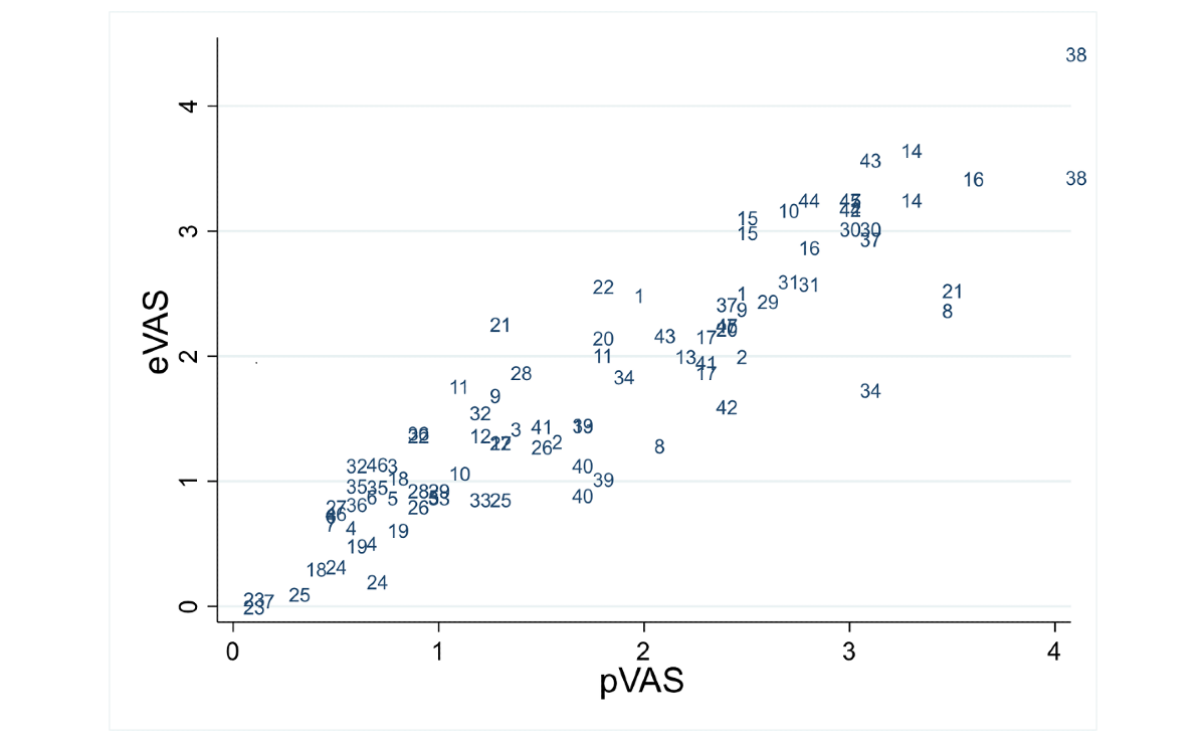
Figure 4. Scatter plot of the data in children and adolescents. Points are represented by subject number. eVAS: electronic visual analog scale; pVAS: paper visual analog scale.